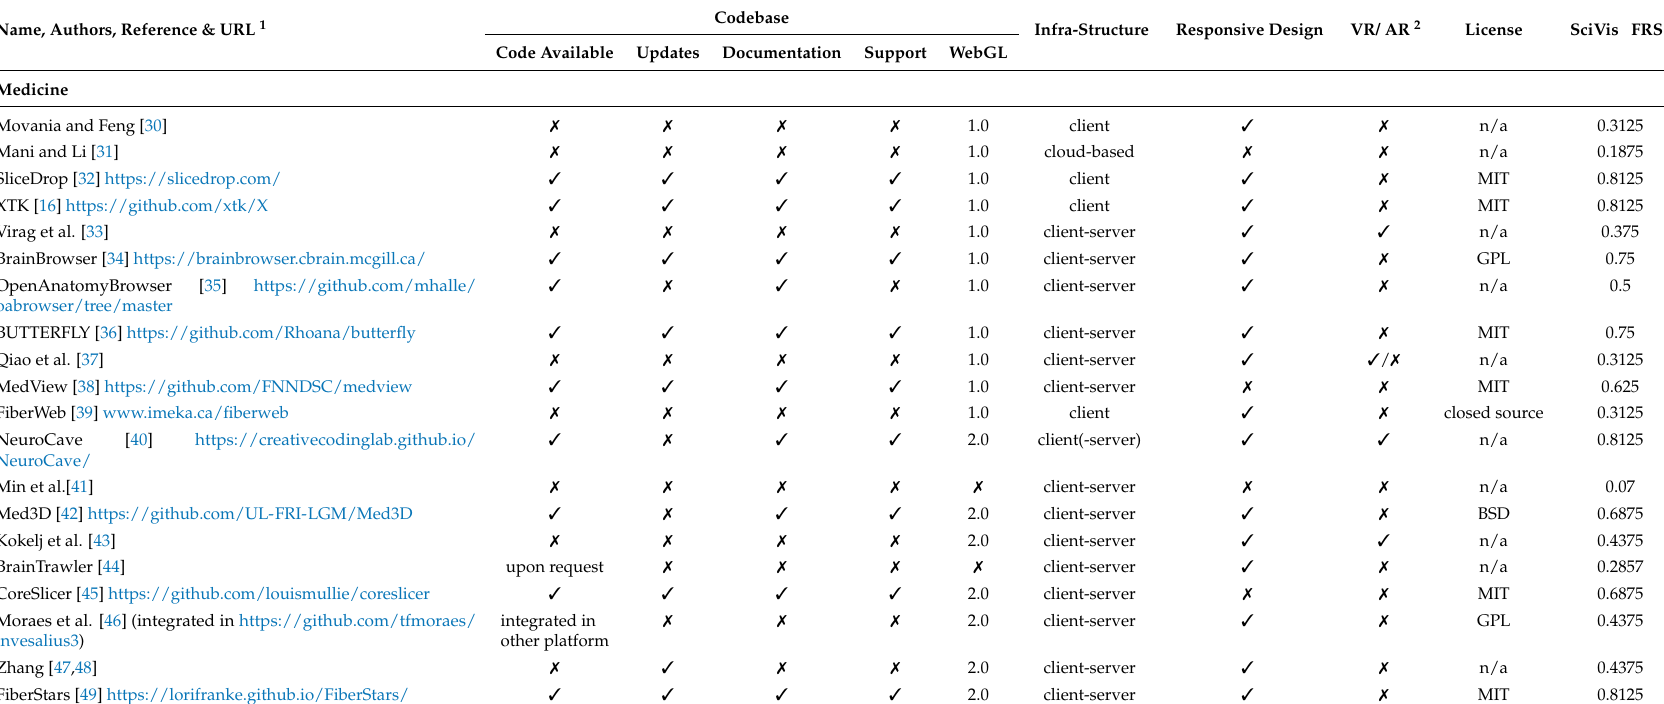
Table 1. Overview of web-based 3D visualization applications and libraries described in the scientific literature based on their key performance indicators and calculated SciVis Future Readiness Score (FRS), sorted by publication year. The provided URLs are either GitHub repositories, links, or demos to the projects belonging to the author’s